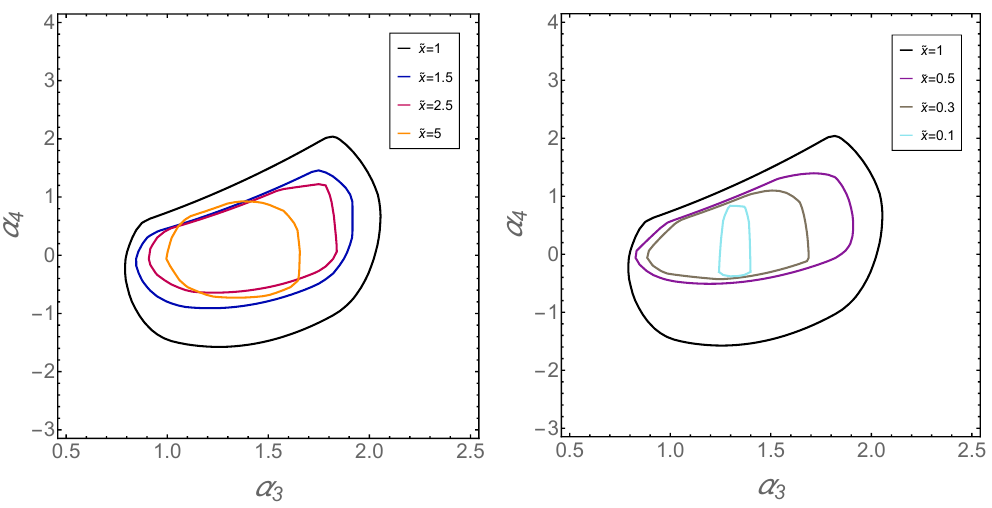
Figure 10 . (Line theory) Positive regions in the ( α 3 , α 4 )-plane for different ˜ x . The regions within the solid lines are allowed by the generalized elastic positivity bounds. We choose β β 4 = − 0 . 1 and γ = 1 .